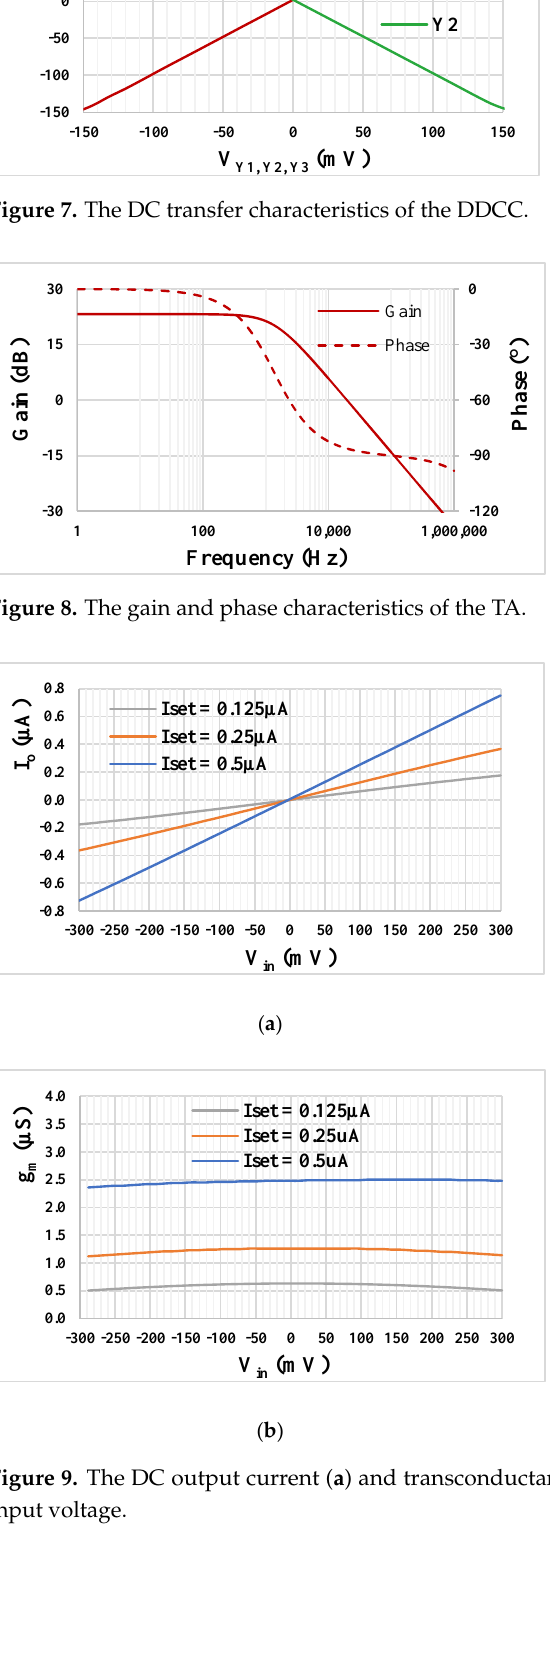
Figure 7. The DC transfer characteristics of the DDCC.